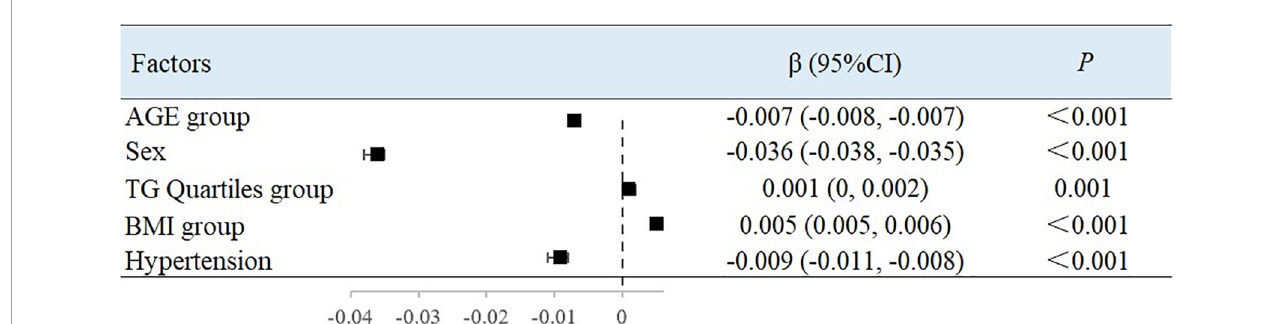
FIGURE2 Factors associated with BAC in multivariate analysis.